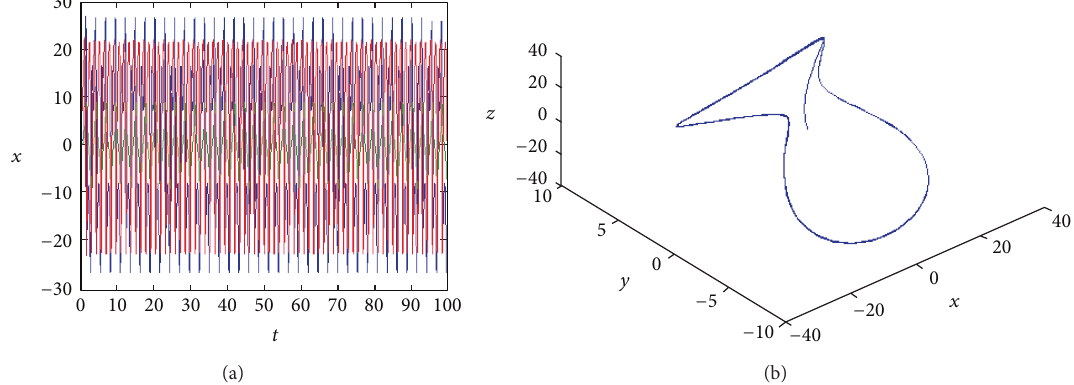
Figure 3: Time history and phase diagram of system (1) with 𝑎 = −0.8 , 𝑏 = 25 .